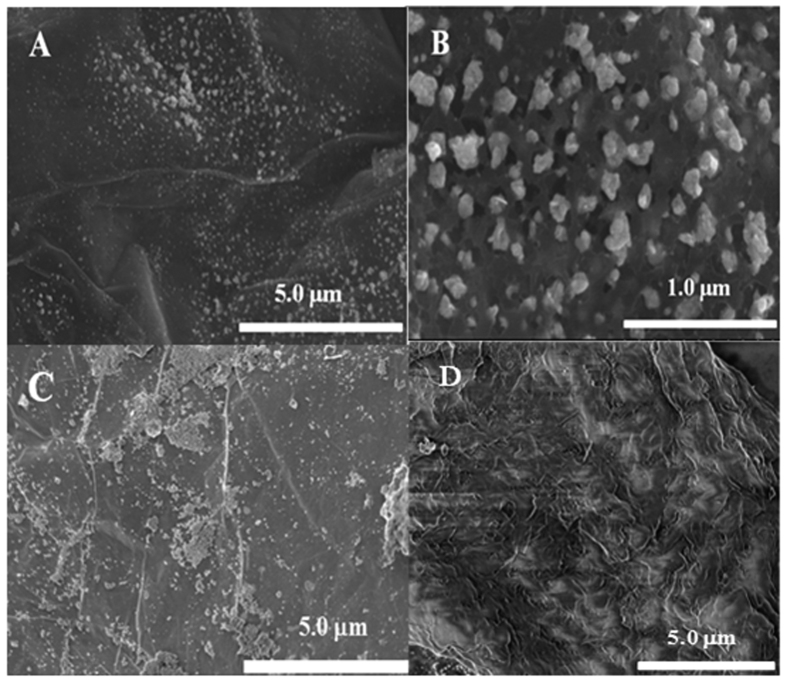
Scanning electron microscopy image of Co3O4/N-rGO (A,B), Co3O4/rGO (C) and N-rGO (D), respectively.